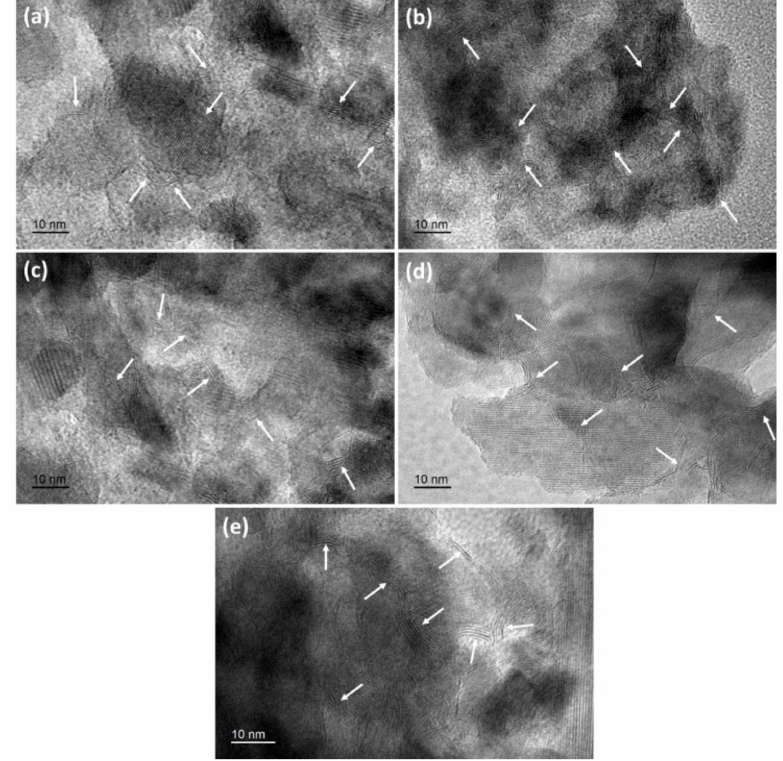
Figure 6. HRTEMimagesofvarioussulfidedcatalysts: ( a )NiMo / TiO 2 -1, ( b )NiMo / TiO 2 -2, ( c )NiMo / TiO 2 -4,